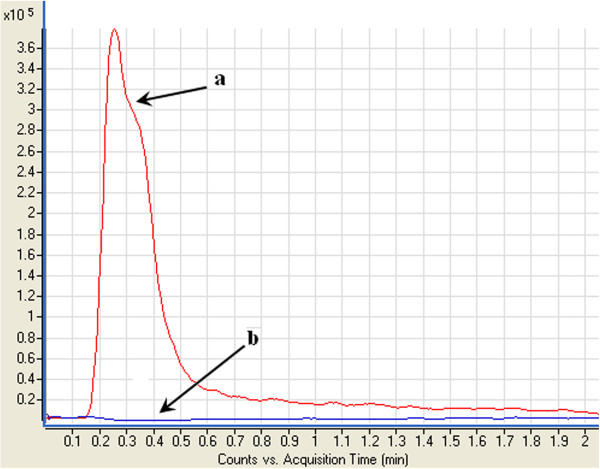
Extracted ion chromatogram at (m/z182) of HHMA (1 μg/mL) in the absence (a) and in the presence (b) of CaCl2 (150 g/L).